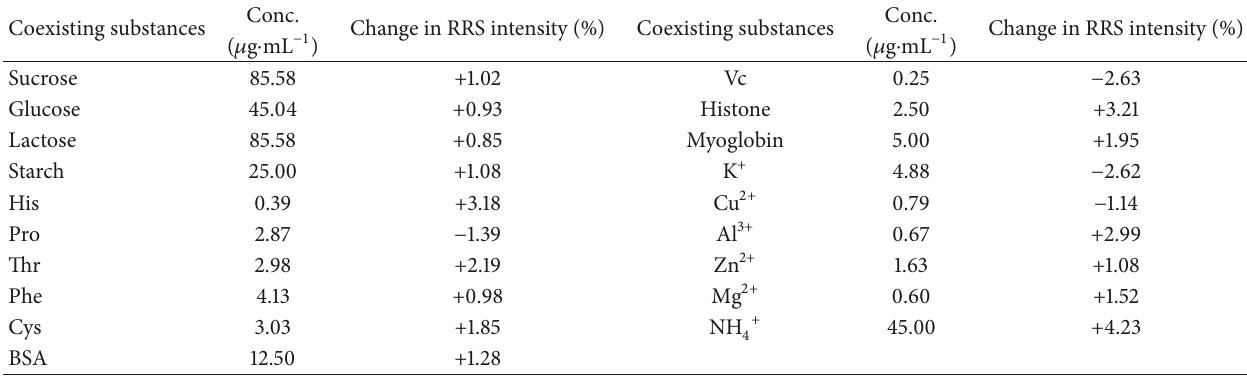
Table 1: Effect of coexisting substances on the FR 𝛼 determination.